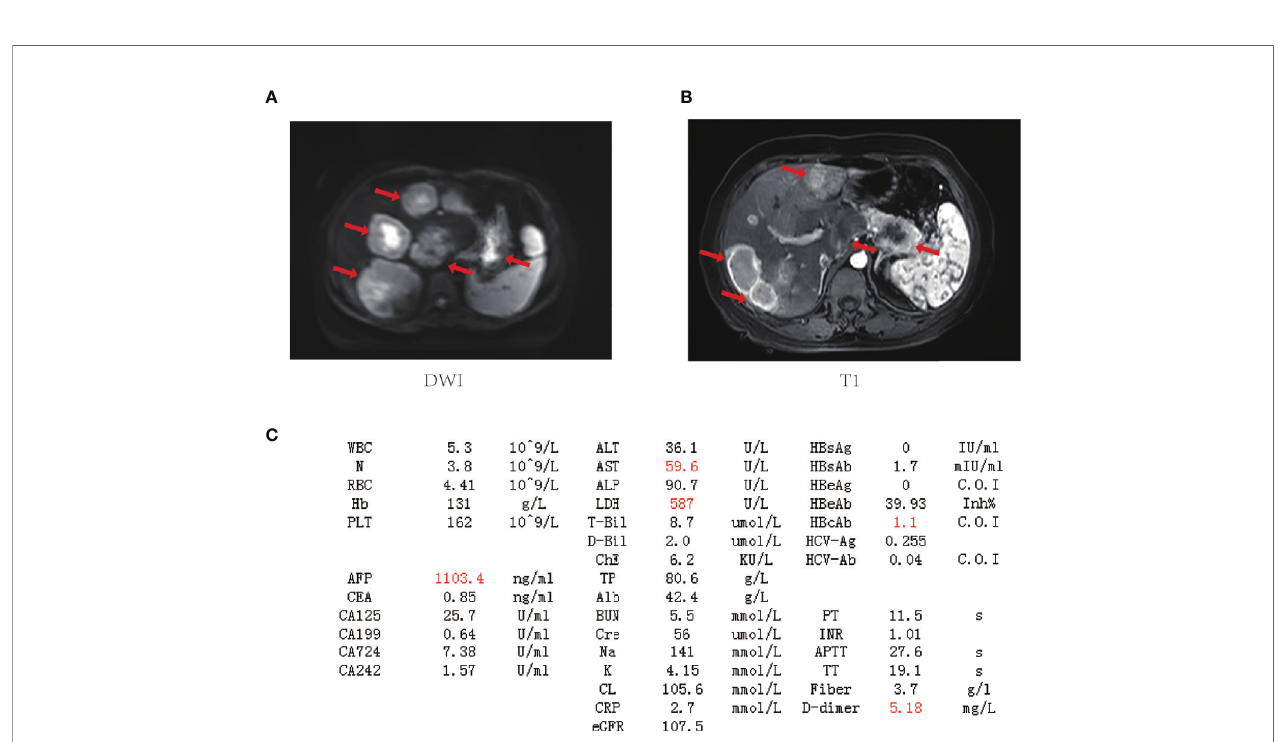
FIGURE 2 | The baseline laboratory and imaging examinations for the patient. (A, B) Magnetic resonance imaging (MRI) of the upper abdomen. Tumor lesions are marked by red arrows. (C) Laboratory data on admission (outliers are highlighted in red). WBC, white blood cell count; N, neutrophil count; RBC, red blood cell count; Hb, hemoglobin; PLT, blood platelet count; AFP, alpha-fetoprotein; CEA, carcinoembryonic antigen; CA125, carbohydrate antigen 125; CA199, carbohydrate antigen 19-9; CA724, carbohydrate antigen 724; CA242, carbohydrate antigen 242; ALT, alanine aminotransferase; AST, aspartate aminotransferase; ALP, alkaline phosphatase; LDH, lactate dehydrogenase; T-Bil, total bilirubin; D-Bil, direct bilirubin; ChE, cholinesterase; TP, total protein; Alb, albumin; BUN, blood urea nitrogen; Cre, creatinine; Na, sodium; K, potassium; CL, chlorine; CRP, C-reactive protein; eGFR, glomerular fi ltration rate; HBsAg, hepatitis B surface antigen; HBsAb, hepatitis B surface antibody; HBeAg, hepatitis B e antigen; HBeAb, hepatitis B e antibody; HBcAg, hepatitis B core antigen; HBcAb, hepatitis B core antibody; HCV- Ag, hepatitis C virus antigen; HCV-Ab, hepatitis C virus antibody; PT, prothrombin time; INR, international normalized ratio; APTT, activated partial thromboplastin time; TT, thrombin